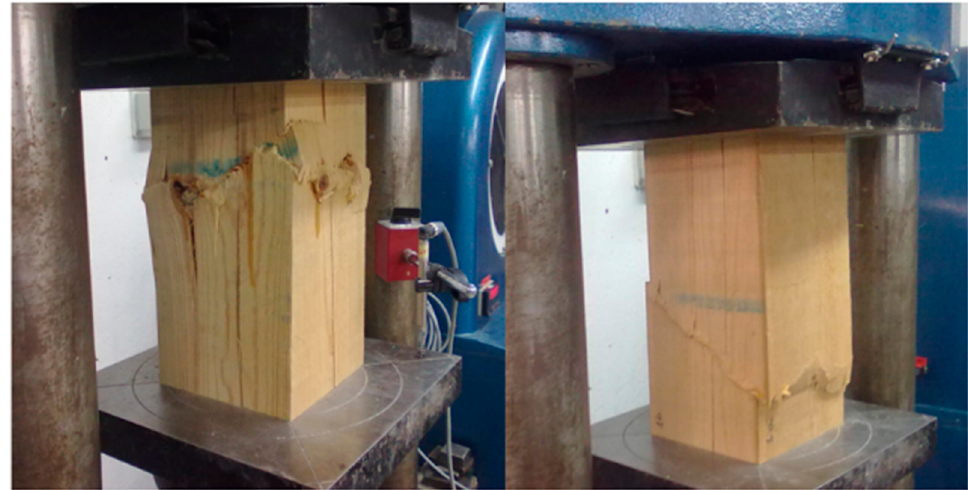
Figure 2. Image of the compression testing of an unreinforced piece of wood.